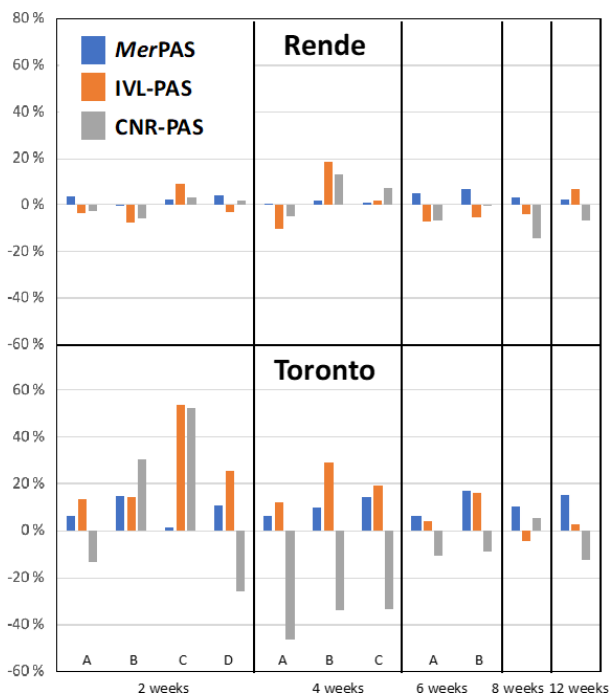
Figure 3. Discrepancies of the time averaged air concentrations of Hg during 22 deployment periods as derived by the three PASs from the average concentration obtained by an active Tekran system de- ployed at the same time. Deployments in Rende/Toronto are dis- played in the upper/lower panel, respectively. Positive/negative dis- crepancies indicate a PAS-derived concentration higher/lower than the Tekran value,